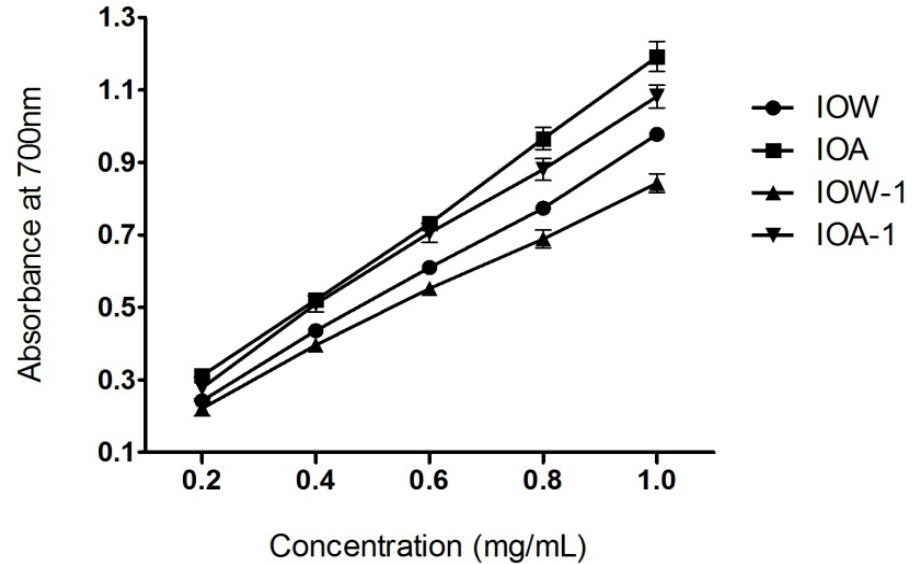
Figure 4. Reducing power.